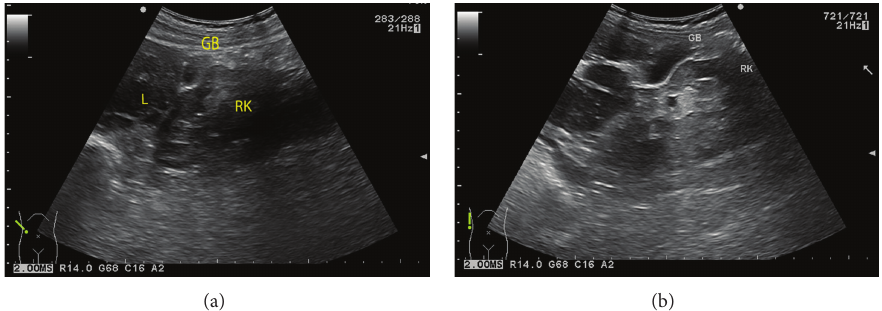
Figure 2: ((a) and (b)): ultrasonography with the probe placed at the right lateral abdominal wall revealed a cystic structure (GB) between the upper pole of the right kidney (RK) and the liver (L).